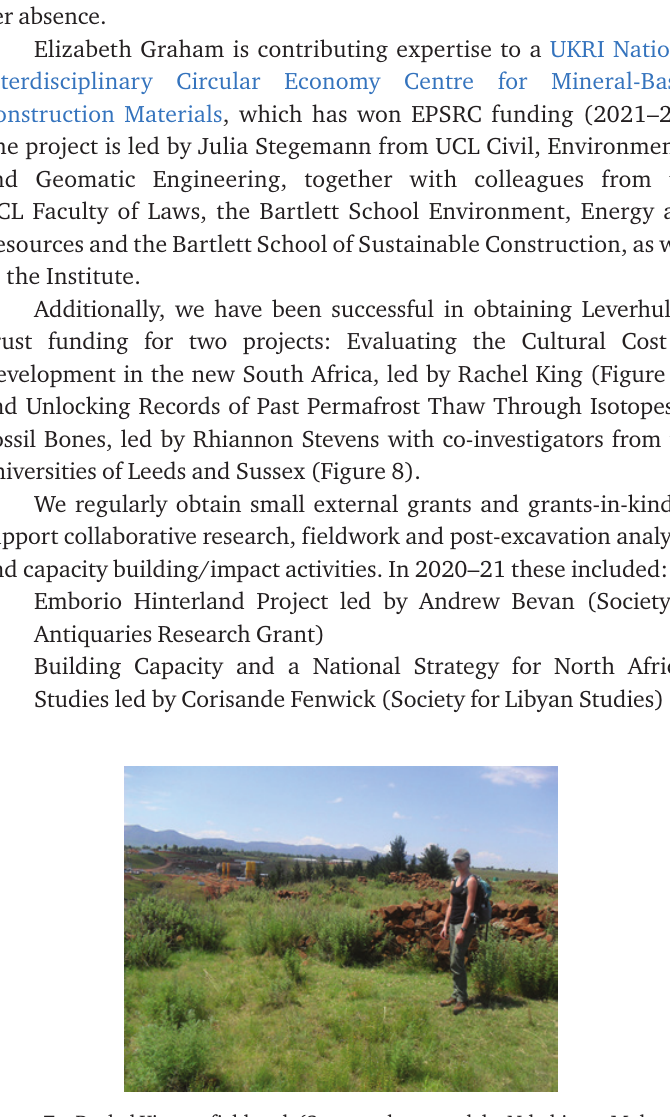
Figure 7 Rachel King on fieldwork (Source: photograph by Nthabiseng